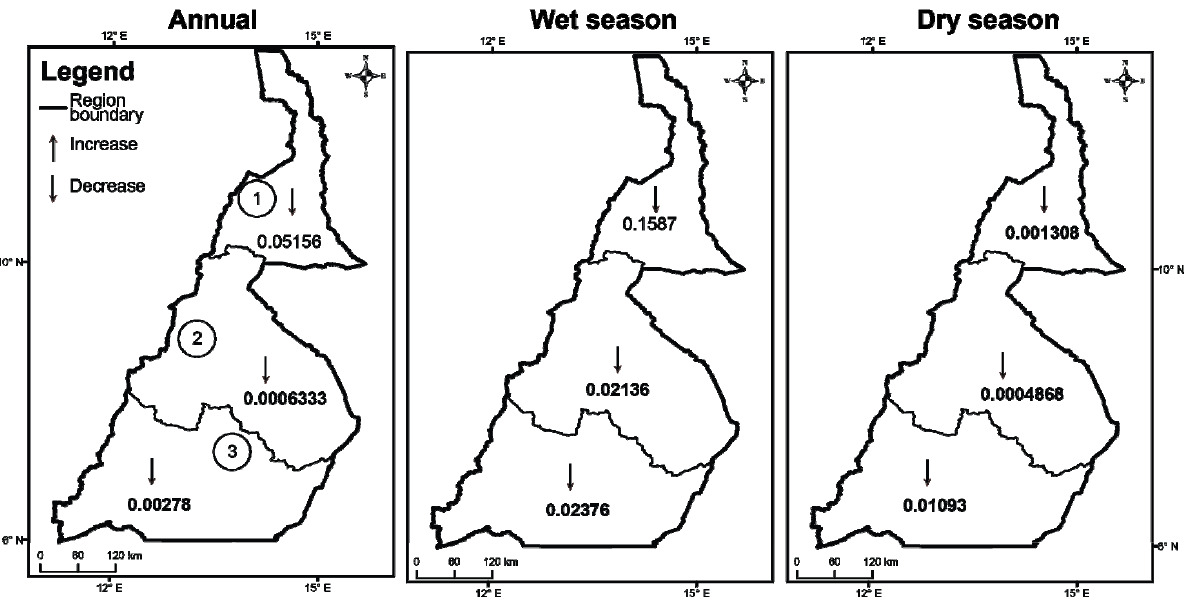
Figure 2. Results of annual and seasonal rainfall for the northern regions of the country (Adamawa (3), North (2), and Far North (1)), using Mann–Kendall’s test. There is a significant trend in the series when the calculated p -values are below the significance level ( α = 0.05). Significant trends are indicated by values in bold.